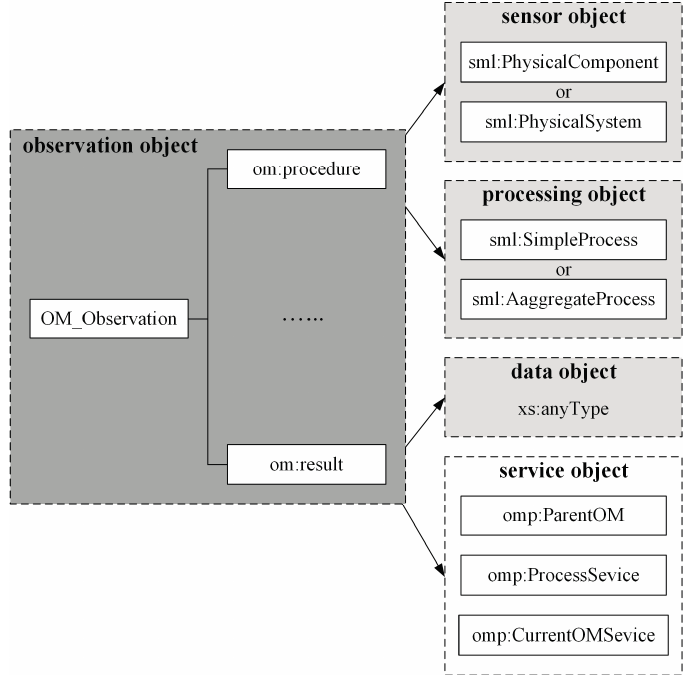
Figure 3. O&M provenance encoding